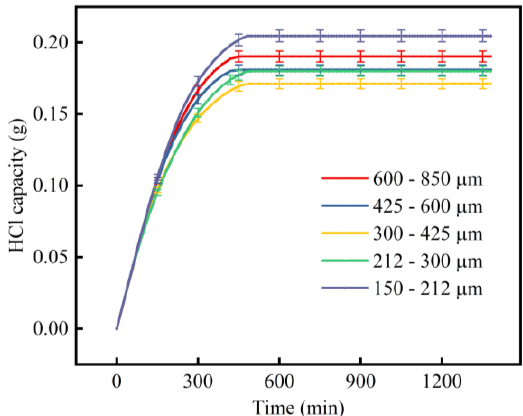
Figure 7. HCl removal capacity with different particle sizes of CaMgAl-LDOs.